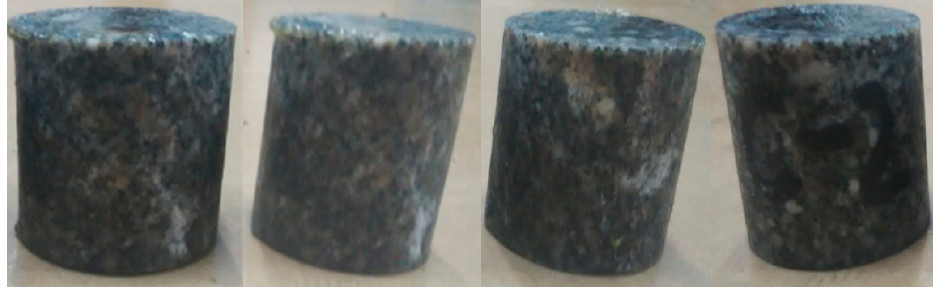
Figure 6. Rock samples after the cycle dynamic impact test.